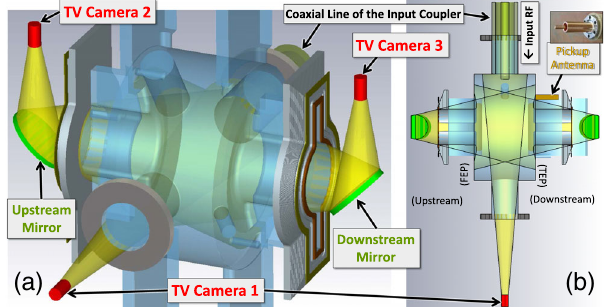
FIG. 5. (a) Schematic of the experimental devices. Red cylinders and yellow regions represent the three TV cameras and their fields of view, respectively. During the high-gradient test, the inside of the cavity (blue) was a vacuum, and the mirrors (green) were contained in the mirror chambers, as shown in Fig. 4. (b) Cross sectionalongthehorizontalplaneincludingthecenterofthecavity.